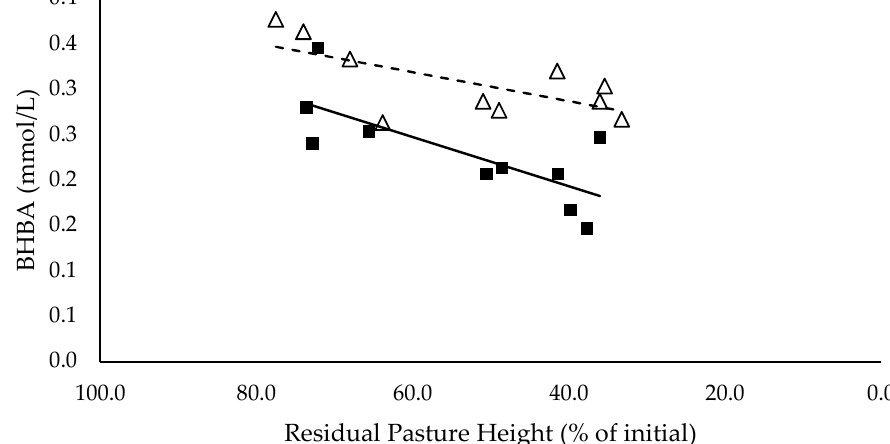
Figure 6. The relationship between the serum β-hydroxybutyrate (BHBA) (mmol/L) and residual pasture height (% of initial) for high ( ■ ) and low (Δ) mixed ration levels. Lines were fitted for high (solid) and low (dashed) mixed ration levels.